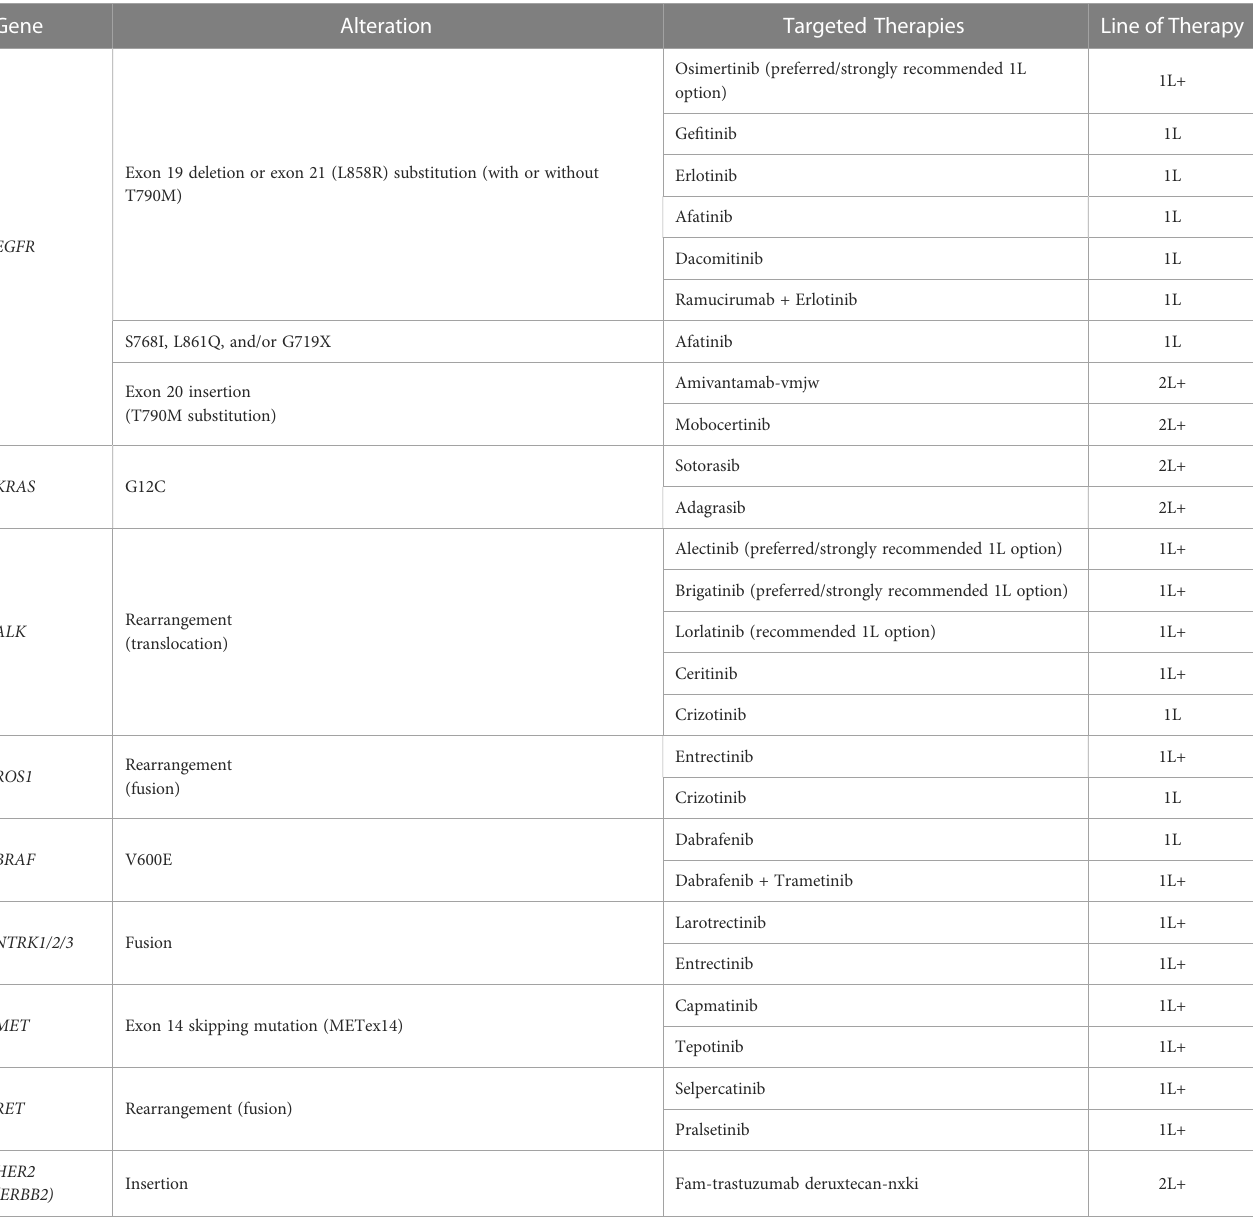
TABLE 1 Recommended Food and Drug Administration (FDA)-approved targeted therapies for treatment of known non-small cell lung cancer genetic alterations (4 – 9). Gene Alteration Targeted Therapies Line of